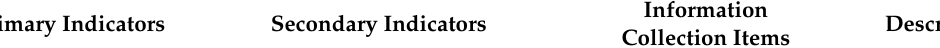
Table 1. Key capability index design and collection items description of Industrial Internet